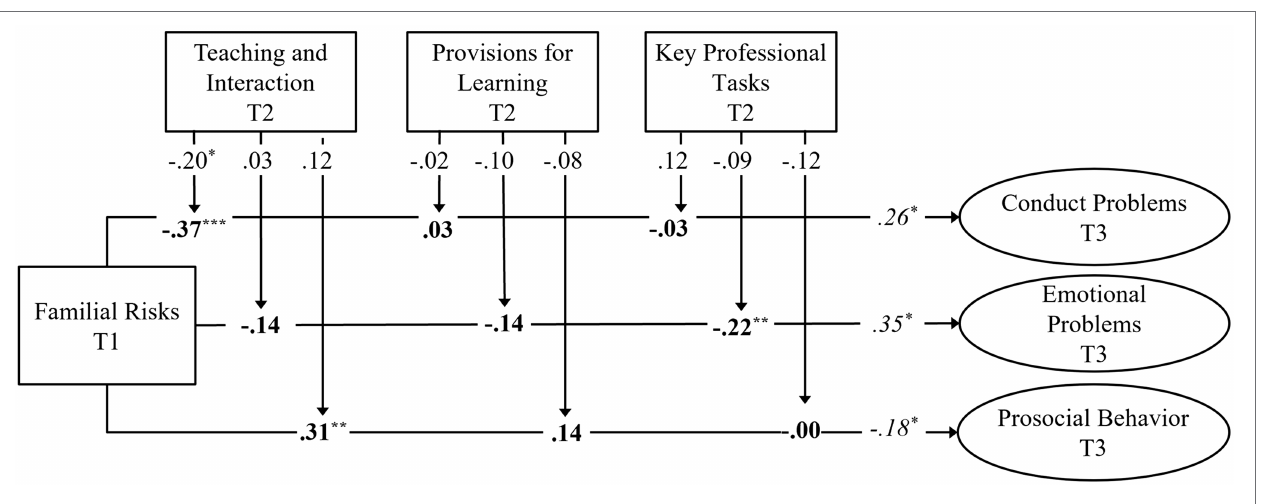
FIGURE 2 | Simplified example of the statistical model for the examination of long-term moderating effects. Bold: Standardized interaction effects (protective effects); Italics : Standardized main effects of early family risks; Plain: Standardized main effects of childcare process quality (promotive effects). The covariates (gender, intensity and duration of childcare attendance, and socio-emotional outcomes at T2) are not shown for simplicity. Results come from nine different structural equation models. T1, T2, and T3 = waves of assessment. * p < 0.05; ** p < 0.01; and *** p <